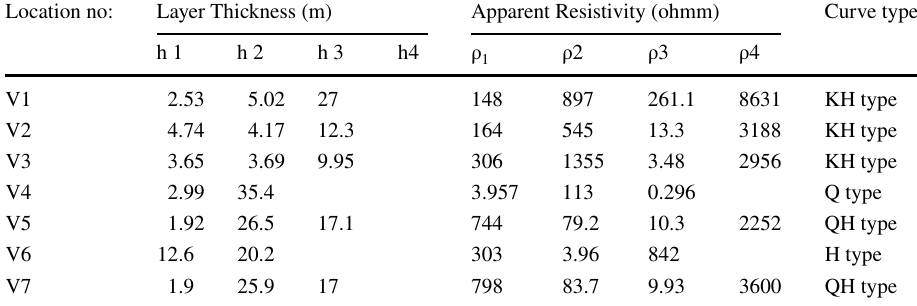
Location no: Layer Thickness (m) Apparent Resistivity (ohmm) Curve sounding (VES) results of Kalanad river basin (Processed by IPI2 win)